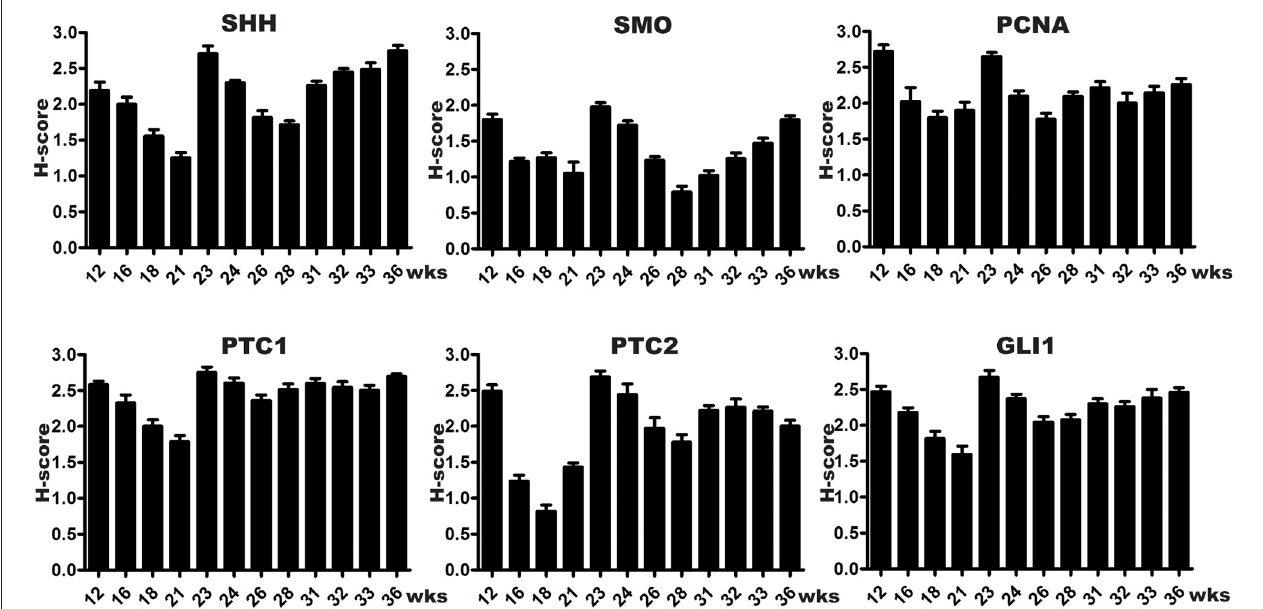
FIGURE 3 | Semi-quantitative histological scoring system (H-scores) of SHH signaling components and PCNA expression in developing human bladders. Every column indicates two samples, and each bar represents the mean SEM (standard error of mean) of H-scores derived from tissue specimens at a specific gestational week. All SHH signaling components were detected in fetal bladder tissues throughout the development, with expression peaks at 12 and 23 weeks (wks), coinciding with high cell proliferation as indicated by PCNA staining in the cell nuclei of developing urothelial and smooth muscle cells. The first expression peak at week 12 wks may relate to urothelium growth, smooth muscle cells induction, and dilation of the bladder cavity. The second expression peak at week 23 wks may relate to urothelium and smooth muscle layer